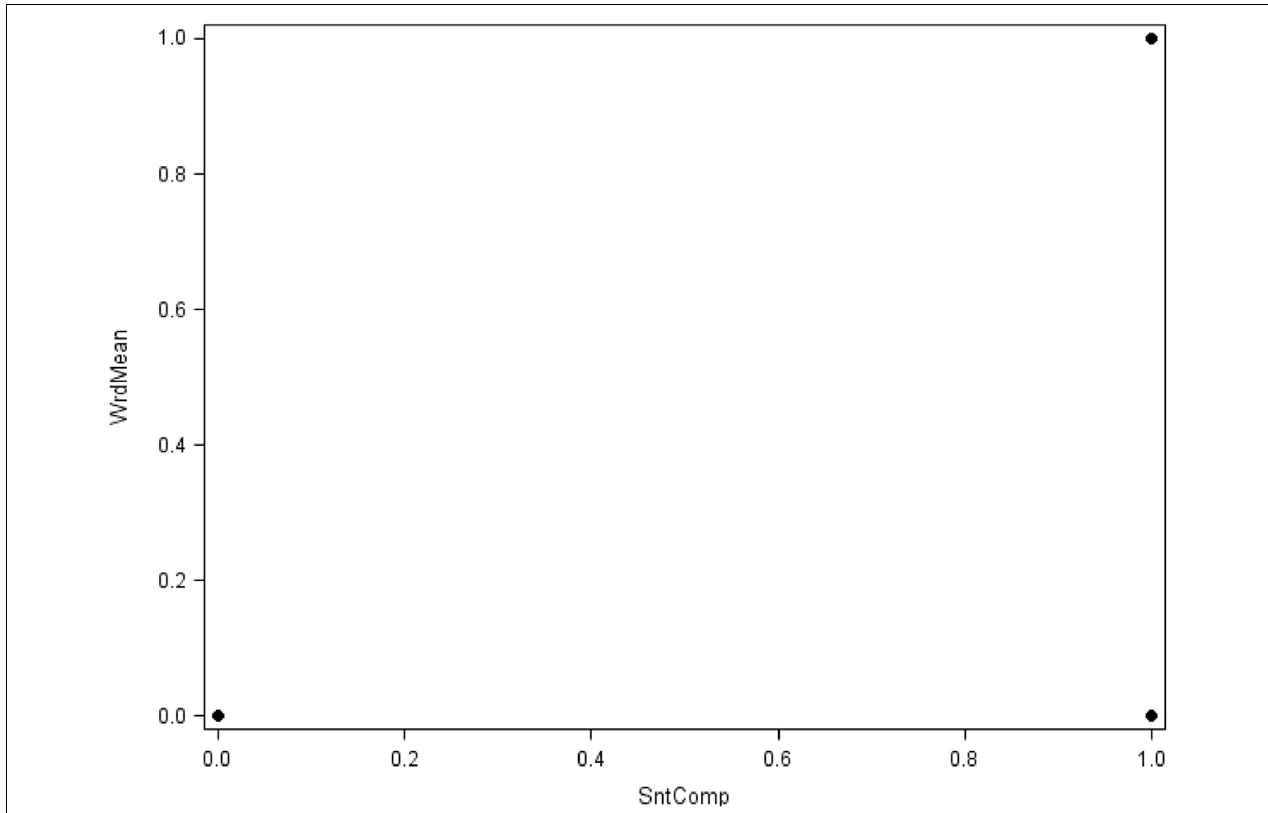
FIGURE 9 | Scatterplot of Case 1 itemsWord Meaning (WrdMean) by Sentence Completion (SntComp; N = 100).